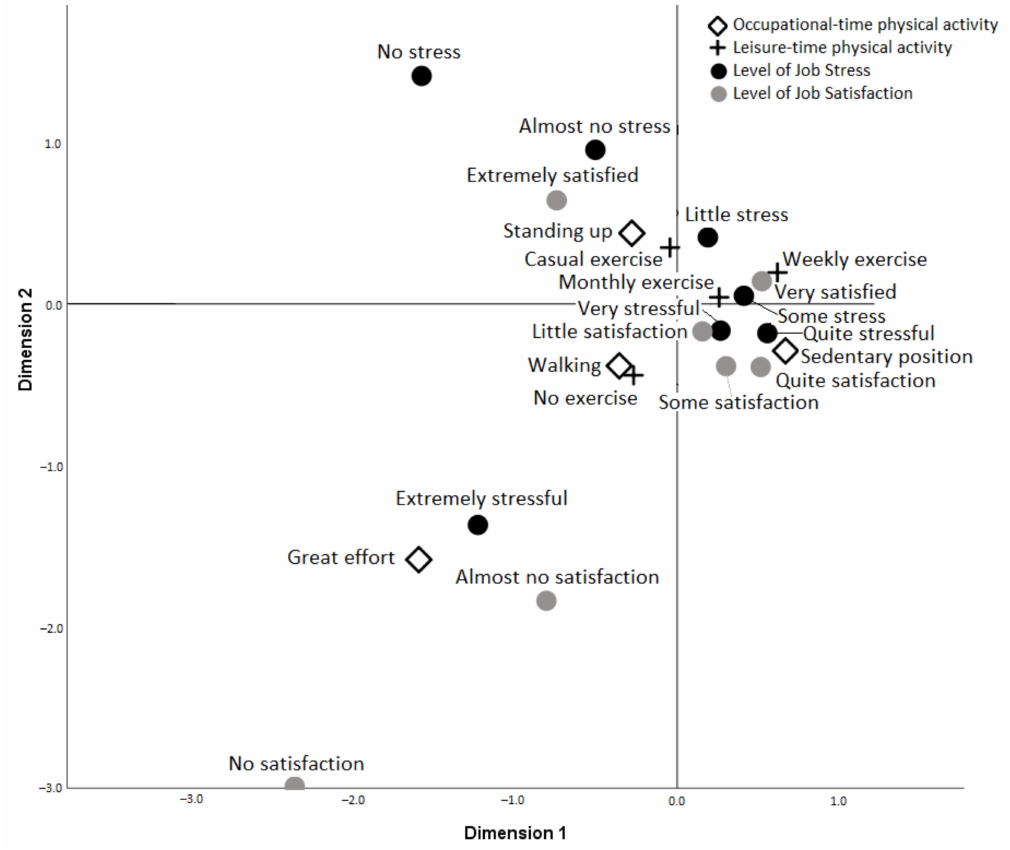
Figure 3. Multiple correspondence analysis